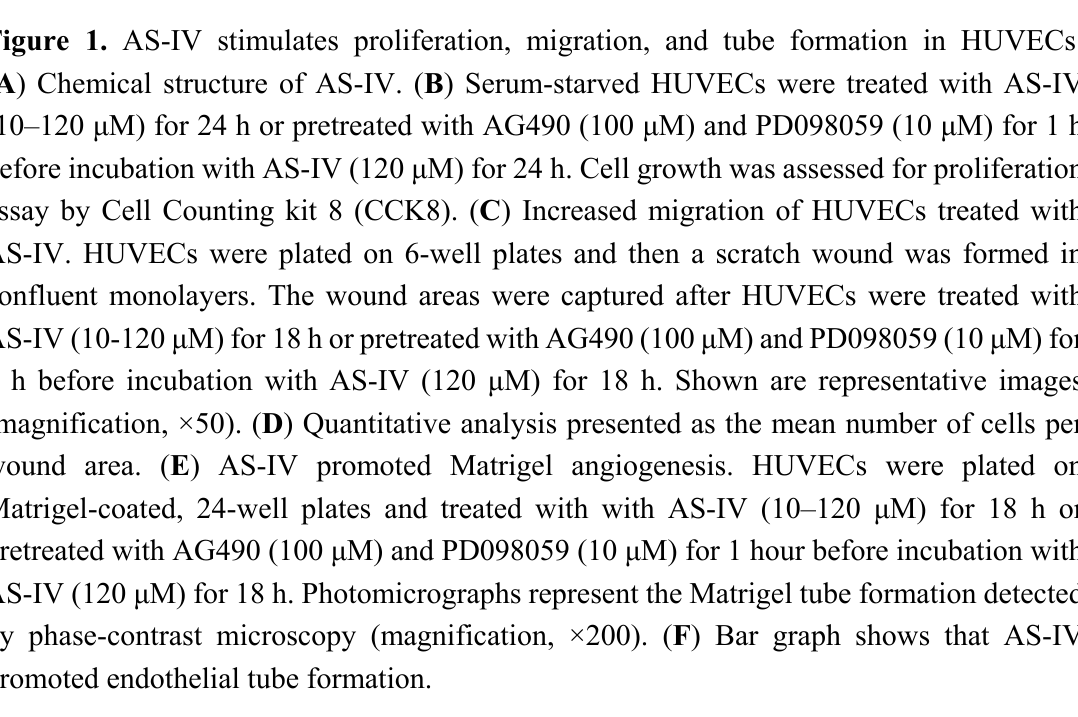
Figure 1. AS-IV stimulates proliferation, migration, and tube formation in